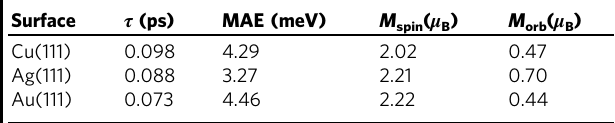
Table 1 Basic calculated properties of Co adatom on Cu, Ag, and Au(111) surfaces.